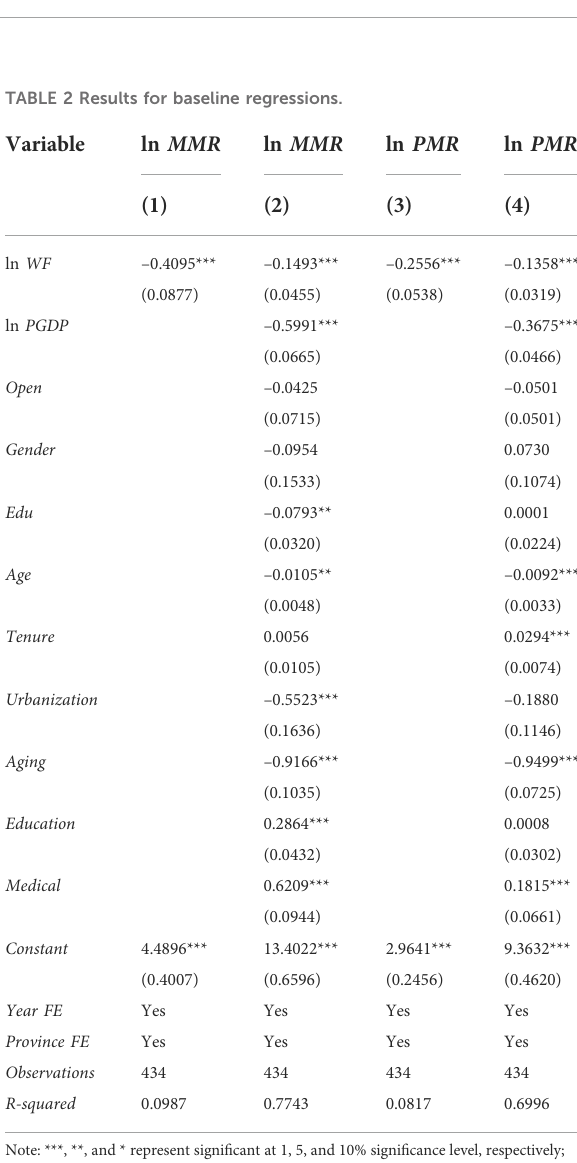
FIGURE 1 Time-series plot of government environmental attention over 2004 – 2017.